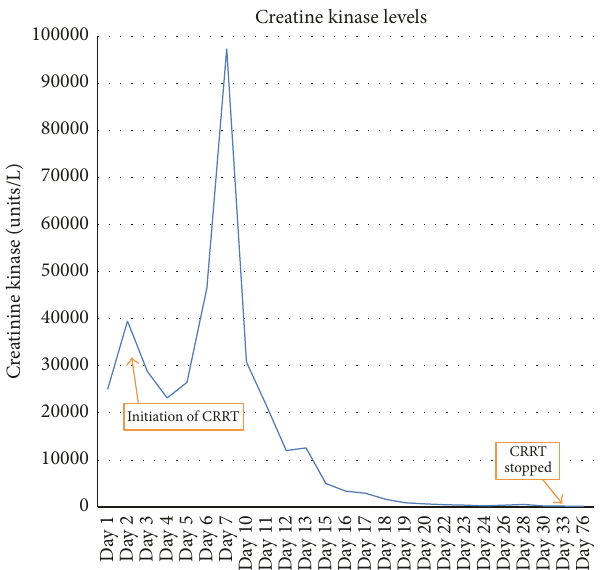
Figure 1: Changes in creatinine kinase levels during the course of patient